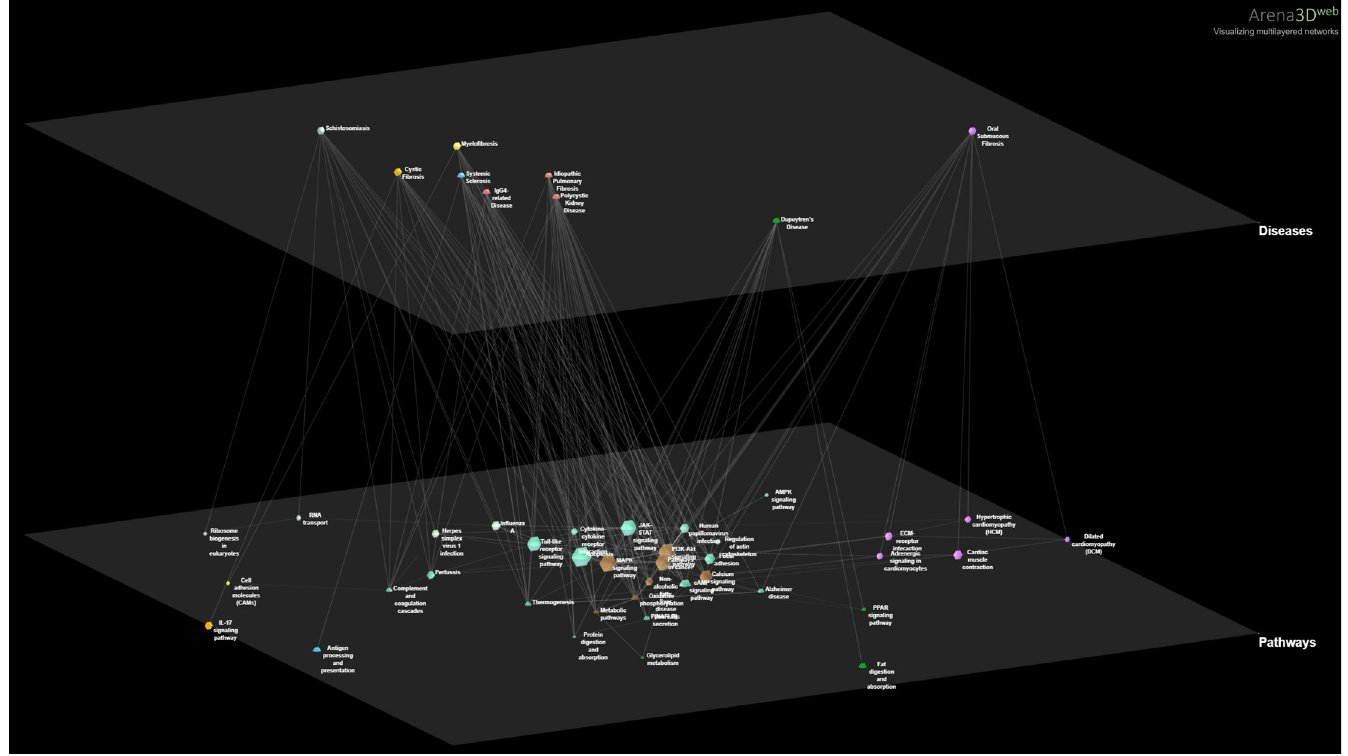
Fig 4. 3D multi-layer visualization for the 9 fibrotic diseases and their highlighted pathways as produced by PathWalks. We observe that 7 pathways are common for all diseases including “Metabolic pathways”, “Pathways in cancer”, “MAPK signaling pathway”, “PI3K-Akt signaling pathway”, “Non-alcoholic fatty liver disease”, “Oxidative phosphorylation” and “Calcium signaling pathway”. We also identify unique highlighted pathways for some of the diseases. The “Cell adhesion molecules” pathway (painted yellow) is exclusive for Myelofibrosis . The “Antigen processing and presentation” pathway (painted blue) is unique for SSc . The “IL-17 signaling” pathway (painted orange) is unique for CF . “Fat digestion and absorption”, “PPAR signaling” and “Glycerolipid metabolism” pathways are unique for Dupuytren’s Disease (painted green). “Influenza A”, “RNA transport”, “Ribosome biogenesis in eukaryotes” and “Herpes simplex virus 1 infection” pathways (painted dark gray) are unique for Schistosomiasis . Finally, “Dilated cardiomyopathy”, “Cardiac muscle contraction”, “Hypertrophic cardiomyopathy”, “Adrenergic signaling in cardiomyocytes” and “ECM-receptor interaction” pathways (painted purple) are unique for OSF . We observe that 4 out of the 5 unique pathways of OSF are related to cardiomyopathies hinting for a novel approach of potential treatments. Such a link between OSF and cardiomyopathies is currently missing from the bibliography.